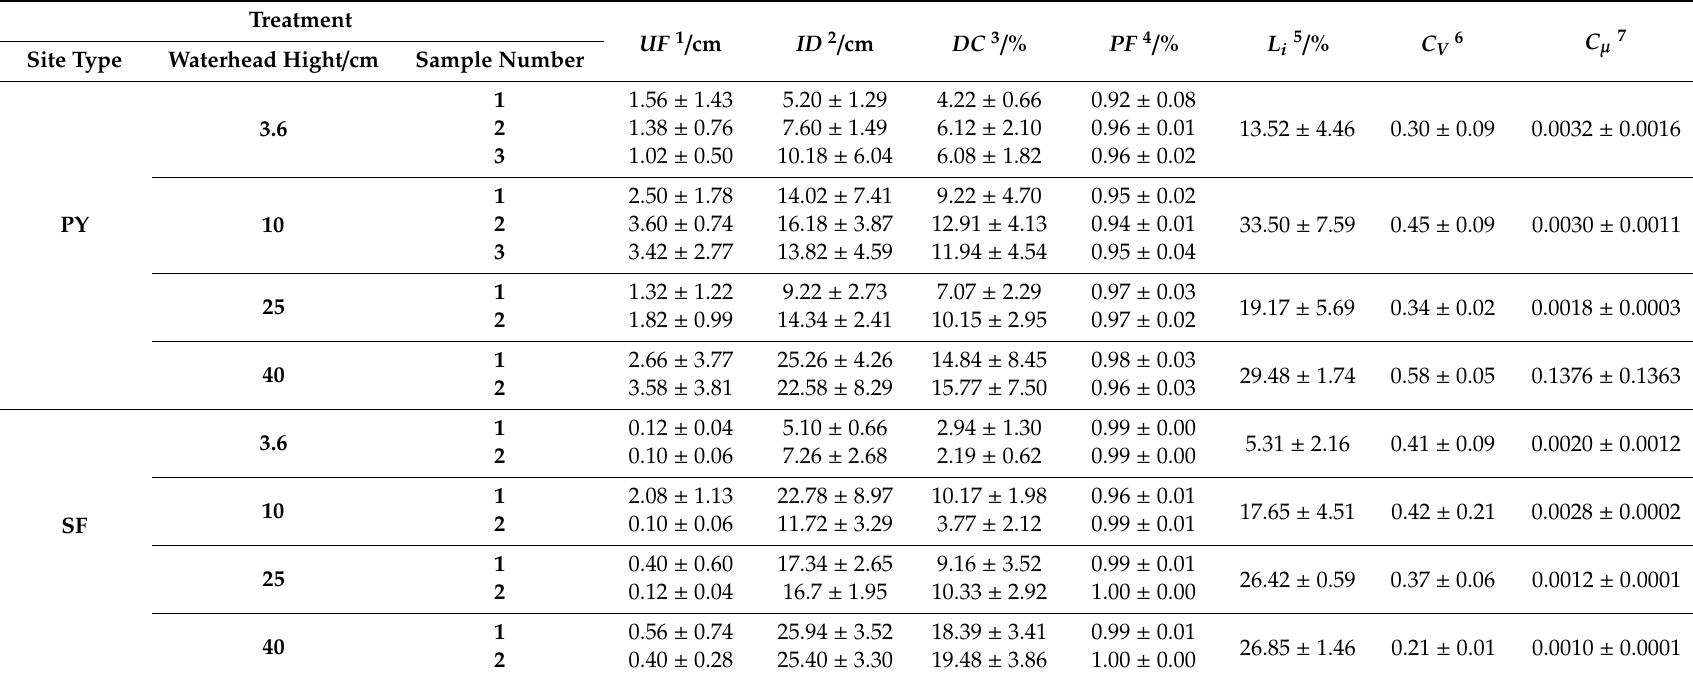
Table 3. Characteristic parameters of preferential flow